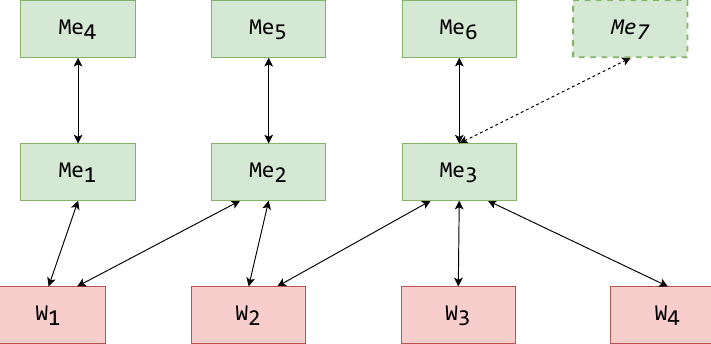
Figure 15. Scenario 1 outcome on a two-layer mediator MW architecture.